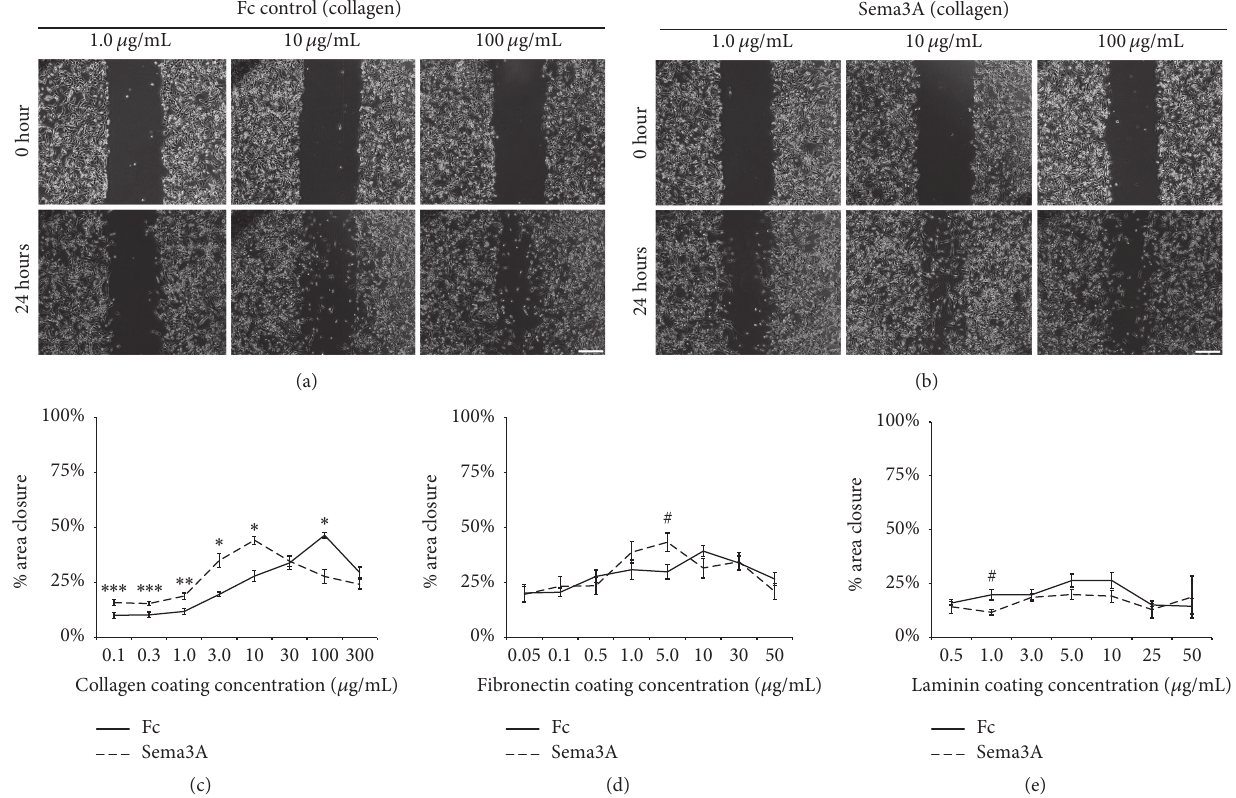
Figure 1: Sema3A enhances cell migration at low coating concentrations of collagen but inhibits migration at high coating concentrations of collagen. ((a) and (b)) Representative images of MDA-MB-231 cells cultured on substrata coated with low (1.0 𝜇 g/mL), intermediate (10 𝜇 g/mL), and high (100 𝜇 g/mL) concentrations of collagen in the presence of 100 𝜇 g/mL IgG1 Fc control or Sema3A. Scale bar = 100 𝜇 m. ((c)–(e)) Cell migration as measured by average % area closure from cells cultured on different coating concentrations of collagen (c), fibronectin (d), or laminin (e) in the presence of IgG1 Fc control or Sema3A. Sema3A enhanced migration at low and intermediate coating concentrations of collagen by 59% and 58%, respectively, but inhibited migration by 40% at high coating concentrations of collagen. However, although Sema3A enhanced migration by 45% at low coating concentrations of fibronectin, there was no statistically significant reduction in migration at high coating concentrations of fibronectin. Overall, Sema3A did not have any significant effect on laminin. Data are presented as mean% area closure ± SEM from a minimum of three independent experiments. ∗ 𝑝 < 0.001 , ∗∗ 𝑝 < 0.005 , ∗∗∗ 𝑝 < 0.01 , and # 𝑝 < 0.05 indicate statistical significance relative to IgG1 Fc control; two-sample 𝑡